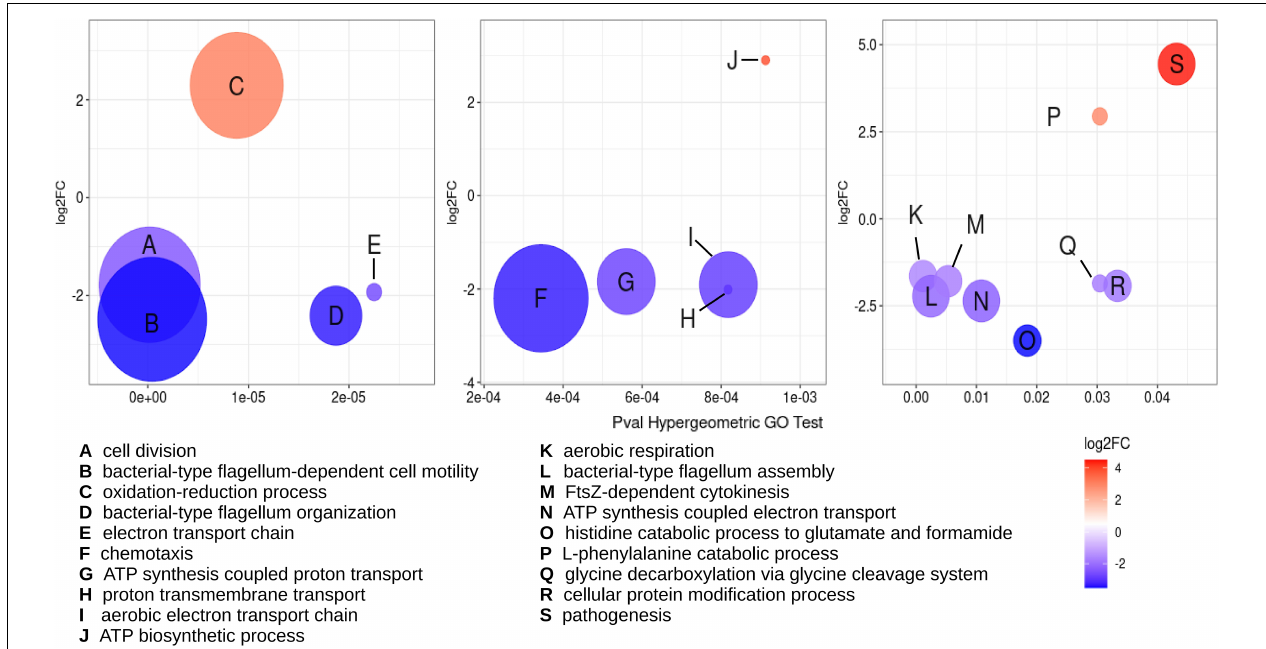
FIGURE 4 | Multiple biological processes are overrepresented among DEGs detected under RdsA depletion. Hypergeometric analysis was used for determination of biological processes overrepresented in the DEGs for the cKD24 mutant, using a p -value cutoff for the hypergeometric GO test ≤ 0.05. Overrepresented GO terms are shown with a letter inside each circle (see legend at the bottom). Circle diameter is proportional to the number of DEGs grouped in a GO term. The upregulated and downregulated DEGs are shown in red and blue circles, respectively, with a cutoff threshold of log2FC ≥ 1.5 and P-adj/FDR ≤